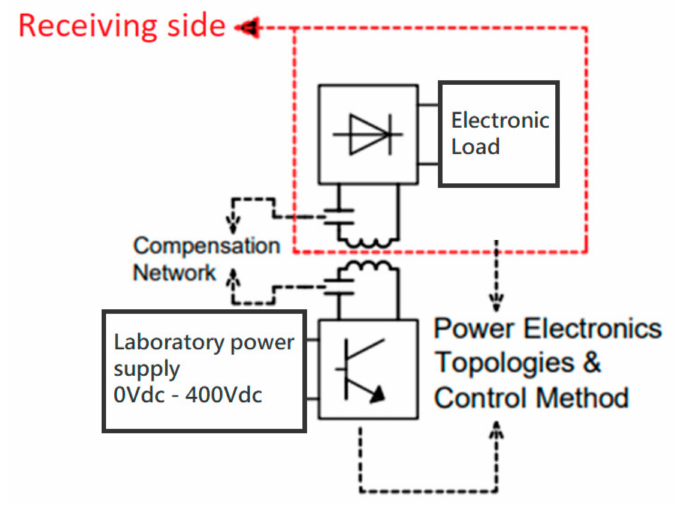
Figure 3. Block diagram of the configuration of the WPT